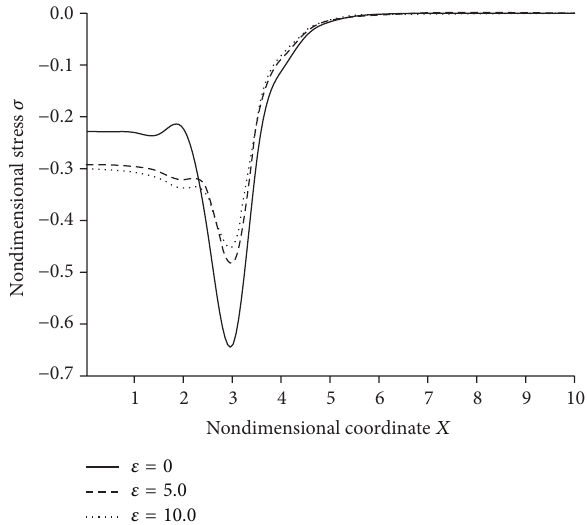
Figure 6: Nondimensional displacement distribution for different 𝜐 values.